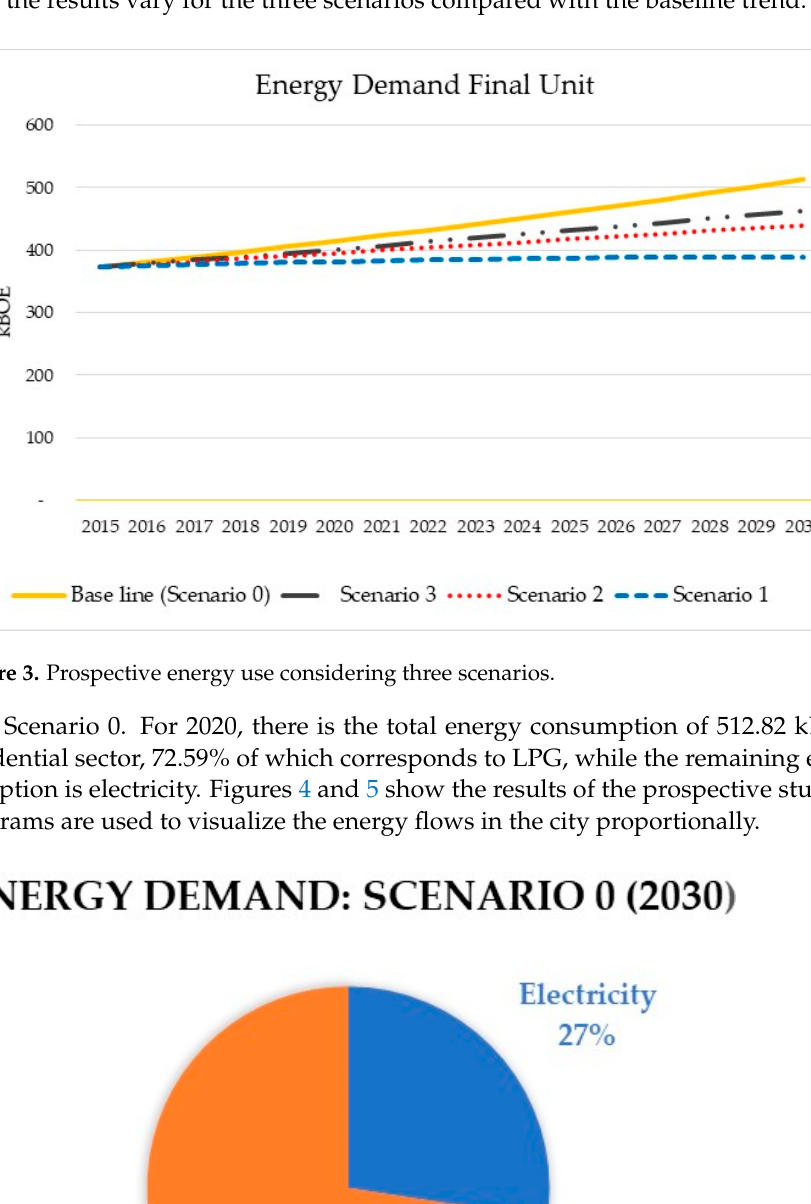
Table 14. Energy consumption for DHW in the base year.